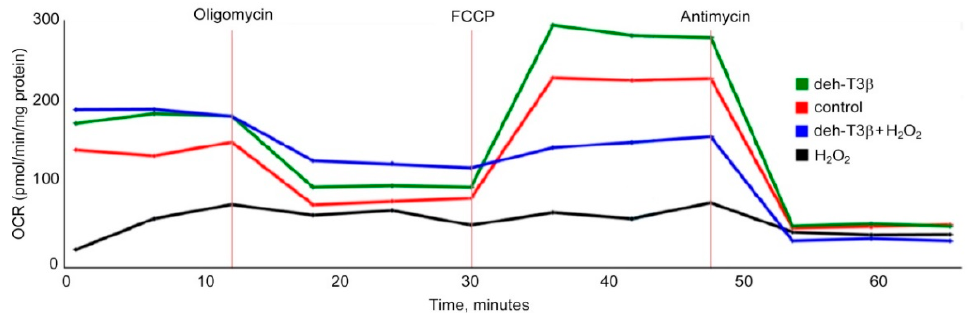
Figure 10. Seahorse respiratory assay in H9C2 cells incubated with deh-T3 β in the presence of H 2 O 2 .